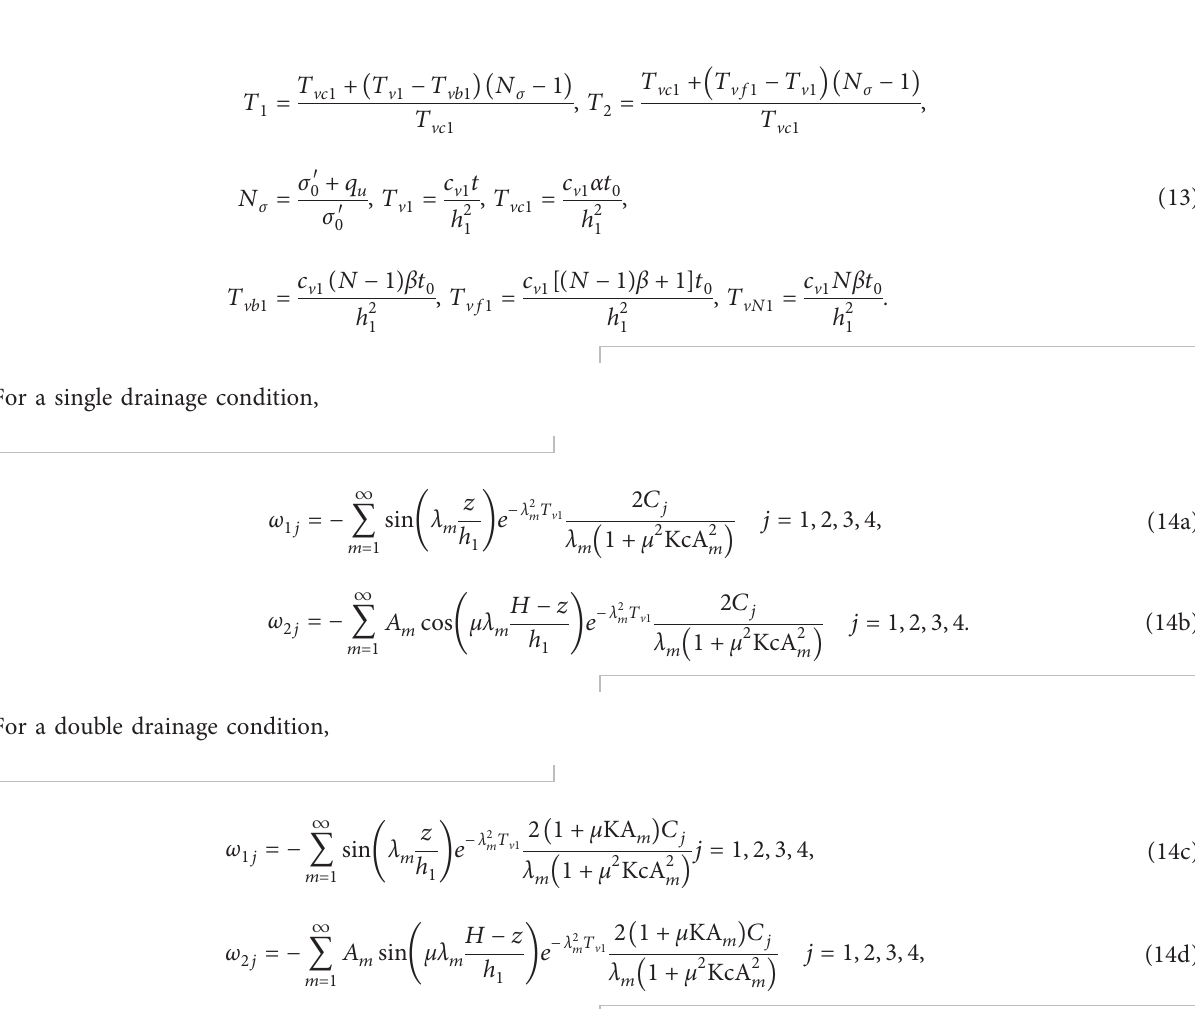
Figure 2: Trapezoidal cyclic